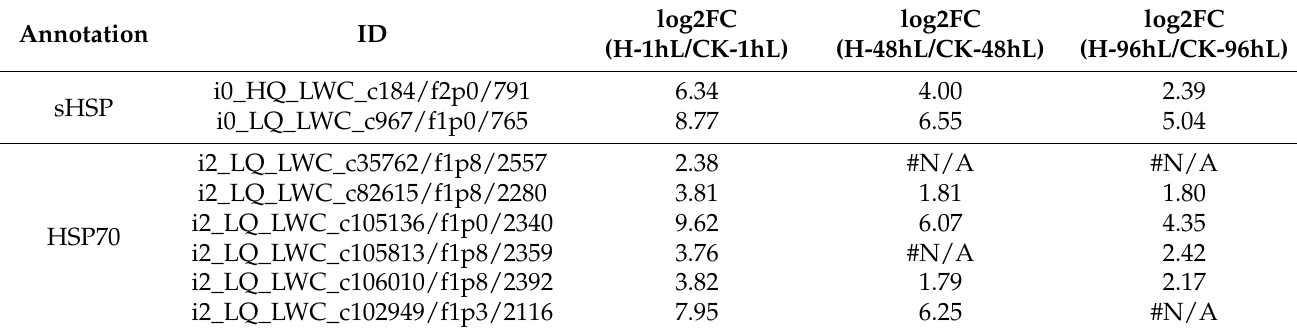
Table 2. Expression of Protein Folding Related Genes in Pearl Millet Leaves under Heat Stress for 1 h.